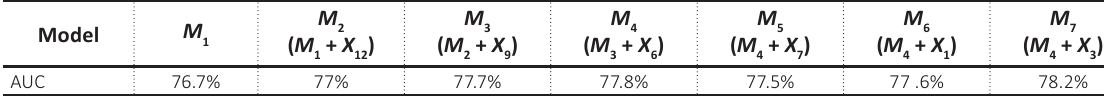
Table B4. Discriminative power of models as a function of variables